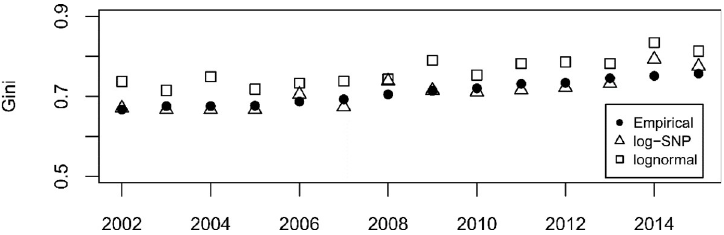
and log-SNP (triangle)